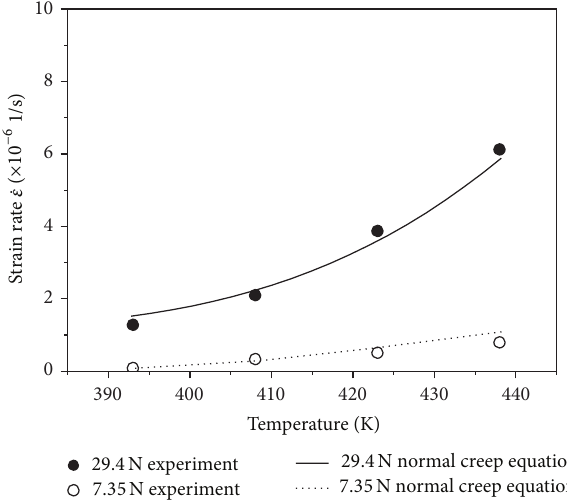
Figure 6: Natural logarithm of the tensile creep experiment strain rate and reciprocal to temperature.